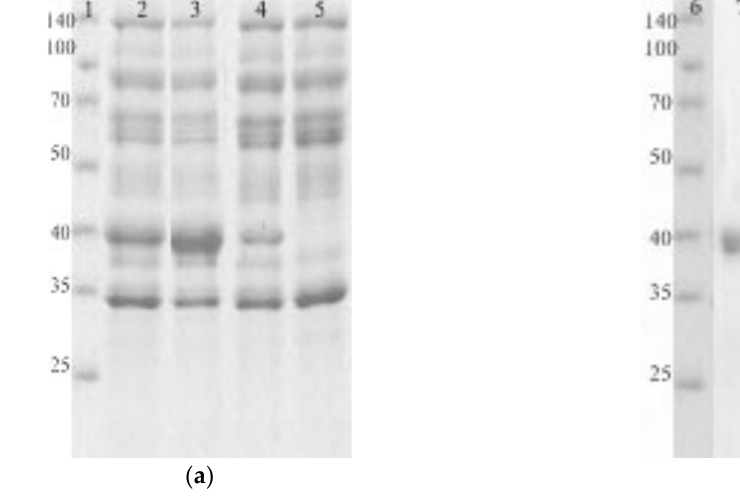
Figure 2. The SDS-PAGEs of culture fluids containing the recombinant EGLII forms ( a ) and purified enzymes ( b ). Lanes 1 and 6 are markers (kDa); lane 2 is the EGLII-DSB2 recombinant strain; lane 3 is the EGLII-DSB3 recombinant strain; lane 4 is the EGLII-wt recombinant strain; lane 5 is the control strain (PCA-10); lane 7 is EGLII-DSB2; lane 8 is EGLII-DSB3; and lane 9 is EGLII-wt.